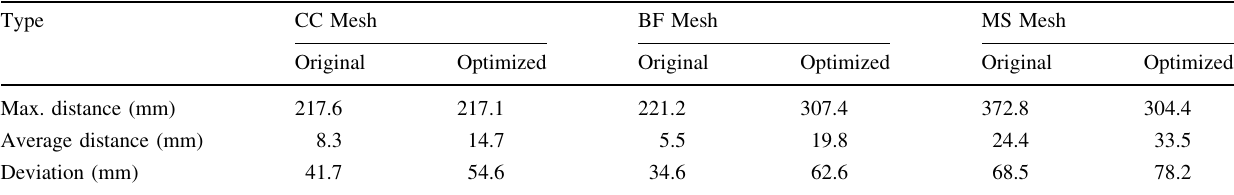
Table 5 Deviation of disturbed point cloud to the Coc Sau